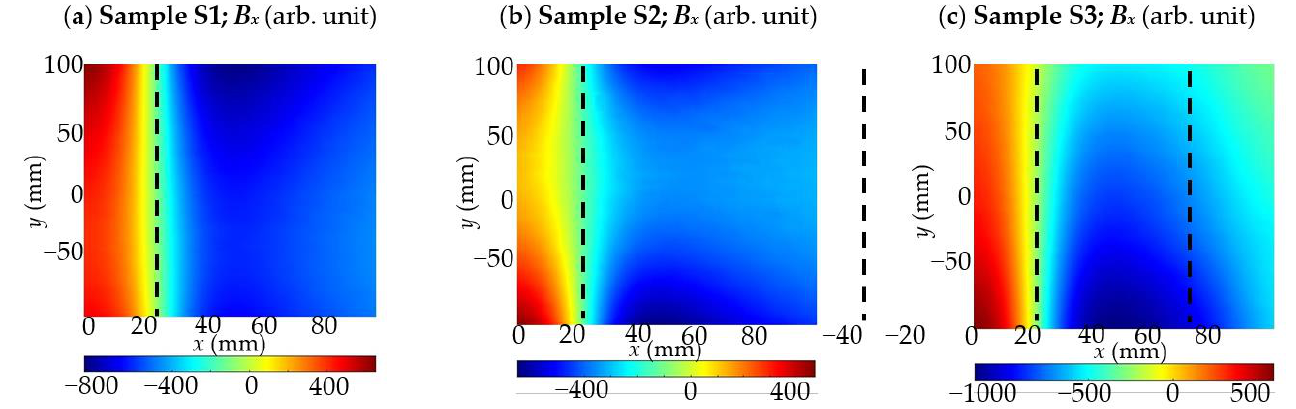
Figure 16. Selected results of 2D measurements of magnetic field component B x with the depicted position of the rebar (dashed line); ( a ) sample S1 — single rebar; ( b ) sample S2 — two rebars one under the other; ( c ) sample S3 — three rebars next to each other.